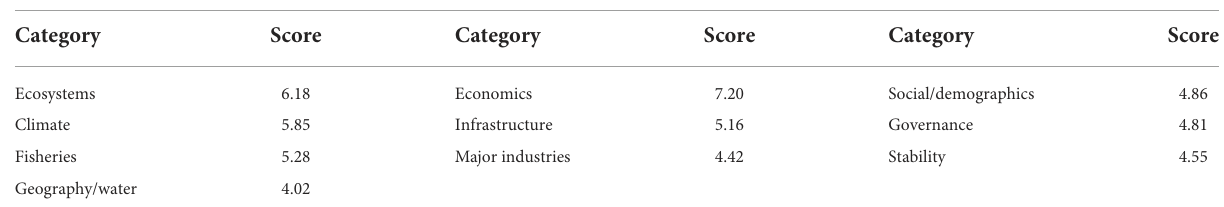
TABLE 3 Castries risk profile summary.